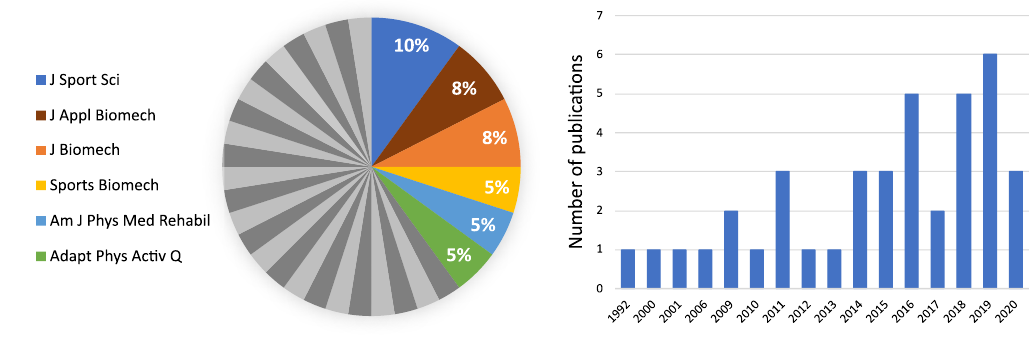
Figure 2. Distribution of included papers over journals (in %, left panel) and time (year of publication, right panel). Journals from which only one paper was retrieved are displayed in dark and light grey.